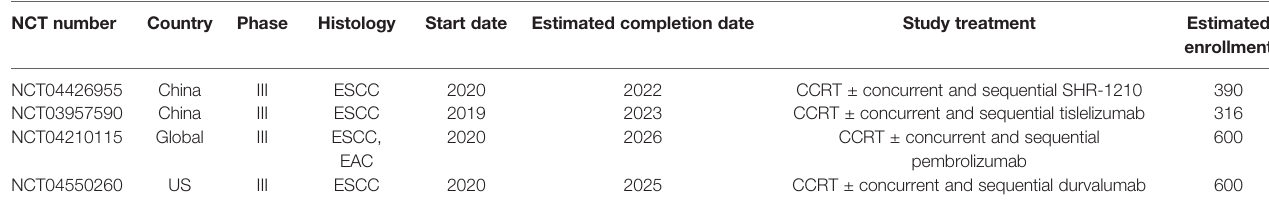
TABLE 7 | Selected ongoing RCTs evaluating immunotherapy combined with CCRT and consolidation immunotherapy.